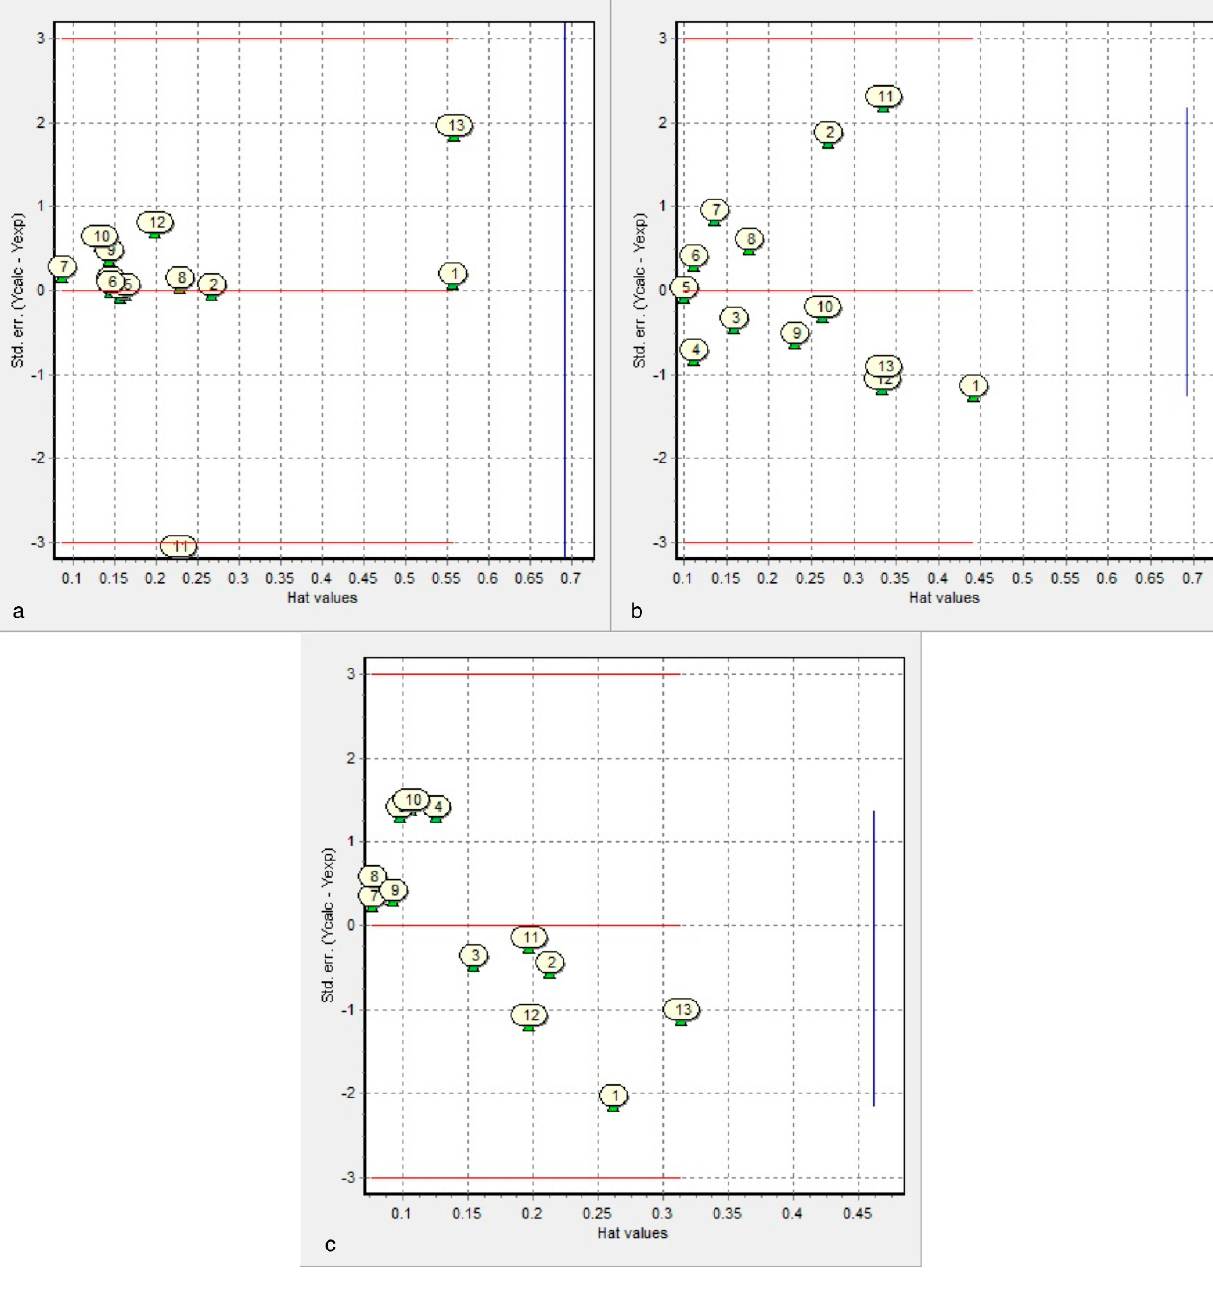
Figure 6. The Williams plot for the graphical visualization of outliers for the response (on the Y -axis: standardized residuals >3 σ ) or for the structure (on the X -axis: highest Hat value > h * cut-off line) in the regression models: ( a ) Equation (1); ( b ) Equation (2); ( c ) Equation (3). Numbers 1–13 correspond to compounds 3 – 12 , 16 – 18 .